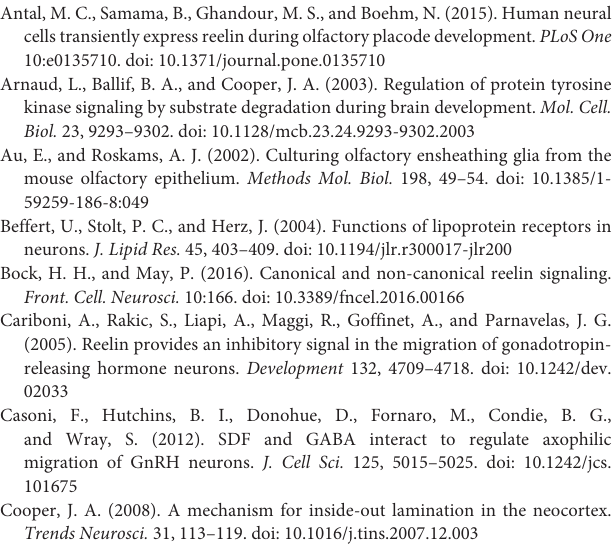
FIGURE S2 | Migration of GnRH neurons exposed to Reelin blocking antibody is rescued by co-incubation of Reelin. Three explants groups were run to validate that the CR-50 antibody was blocking the Reelin pathway. One group received G10 (an antibody with no known functional effects, control), one group received CR-50 (mutant-like) and the third group received CR-50 + Reelin (rescue). None of the treatments had an effect on the total number of GnRH cell in the periphery (GnRH: 229 ± 50 [mutant-like], 247 ± 89 [Control], 253 ± 85 [Rescue] N = 5 for each group). (A) The cumulative frequency of the distribution of GnRH cells in the periphery of explants treated with CR-50 and CR-50/Reelin is plotted. Exogenous Reelin blocked the effect of CR-50 (Kolmogorov-Smirnov (KS), p < 0.001), allowing GnRH cells to migrate further into the periphery (especially close to the endogenous reelin source which is at the tip of the nasal cartilage 0 on x -axis) (B) . The cumulative frequency of the distribution of GnRH cells in the periphery of explants treated with G10 and CR-50/Reelin is plotted. No difference between the Control and Rescue groups was found (KS, p >